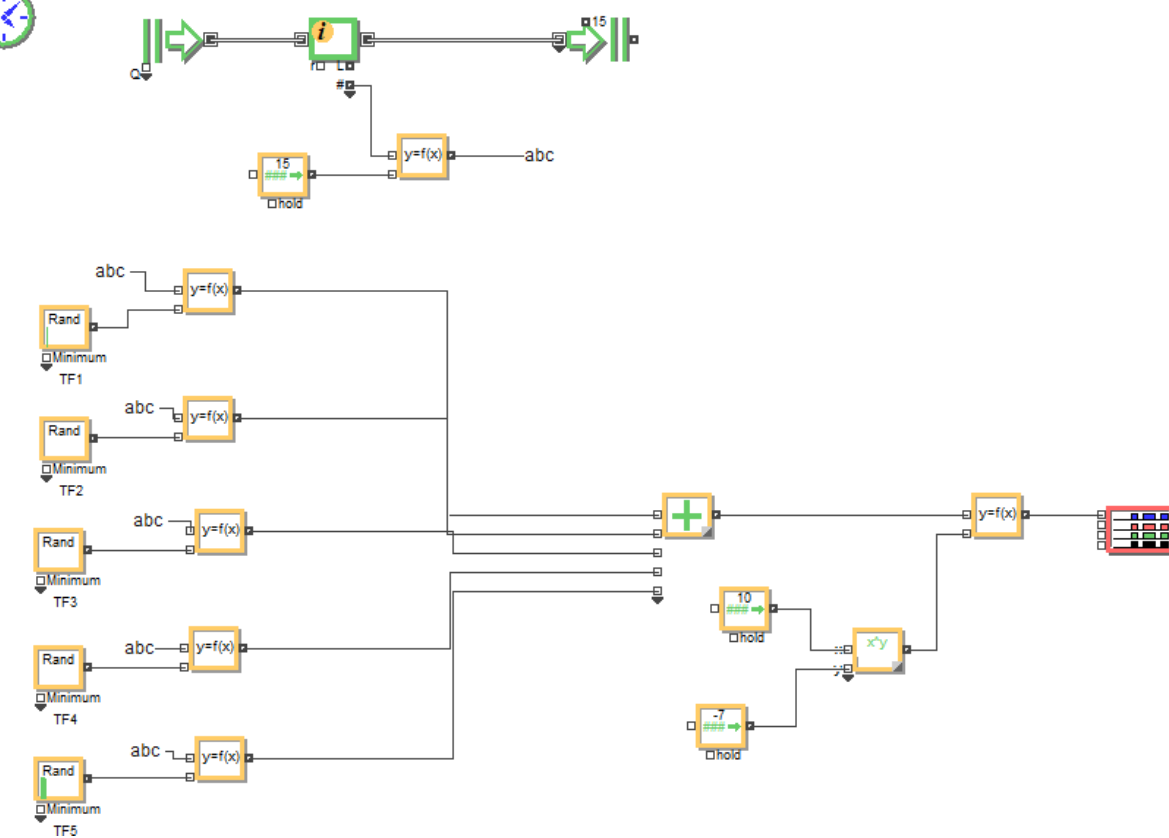
The model is divided into three parts. The first part of the model is created by blocks for input and output of in- formation generated in the other parts of the model. The second part of the model is created by the blocks with en- tered tension forces of rollers in the idler station of the pipe conveyor. Each of the rollers consists of the blocks “Ran- dom Number” and “Equation” with entered maximum and minimum value of the tension force. Table 1 presents the values of maximum and minimum tension forces of simu- lation.